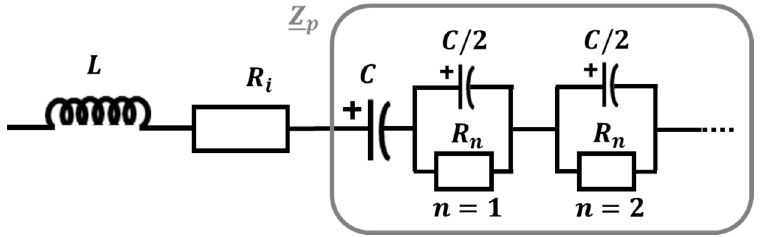
Figure 1. SC frequency domain model proposed by Buller et al (adapted from [19]).